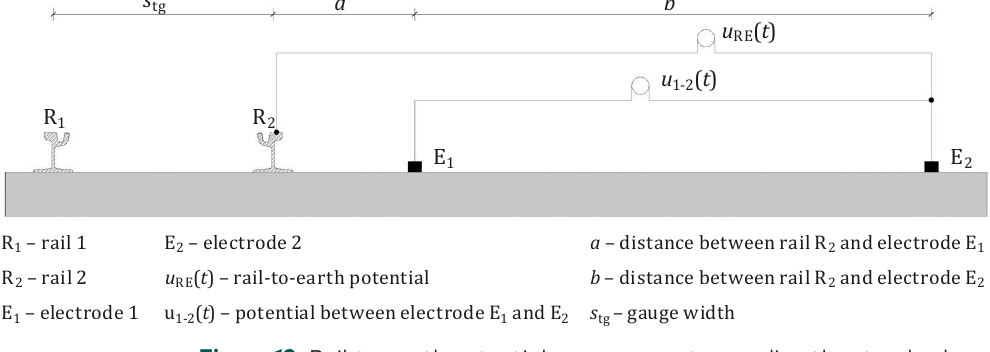
Figure 12. Rail-to-earth potential measurement according the